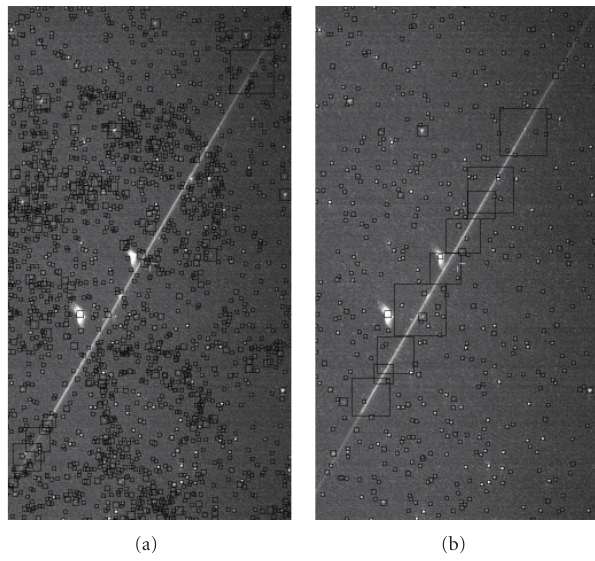
Figure 8: A 5 ◦ × 9 ◦ image with a bolide. The black squares indicate objects extracted from the frame. The side of the square corresponds to the FWHM of the object. (a) shows a frame with objects extracted using standard SExtractor parameters (with the extraction threshold of S/N > 1 . 5) with no filters applied. As a result, the program identified all Star-like objects, heaps of faint garbage, hot pixels, and simply random noise, that is, virtually everything except the bolide. (b) shows the result of extraction made using the currently adopted refined custom parameters. Several bright elongated objects are extracted on the bolide image and the noise level is appreciably